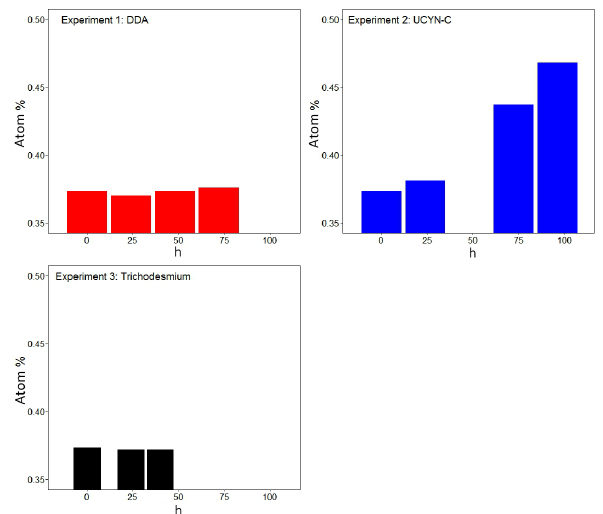
Figure 7. Atomic percent of enrichment of zooplankton in three 15 N 2 labelled diazotroph grazing experiments. The dominant dia- zotrophs in Experiments 1, 2, and 4 were DDA (het-1: Richelia as- sociated with Rhizosolenia ), UCYN-C, and Trichodesmium spp., re- spectively. Zooplankton T0 atomic percent of enrichment was mea- sured in triplicate for E1 and the average value was used as the baseline for E1, E2, and E4. The atomic percent of enrichment of the diazotroph community after 24h was 1.515% for UCYN-C and 0.613% for Trichodesmium spp. No enrichment value was obtained for